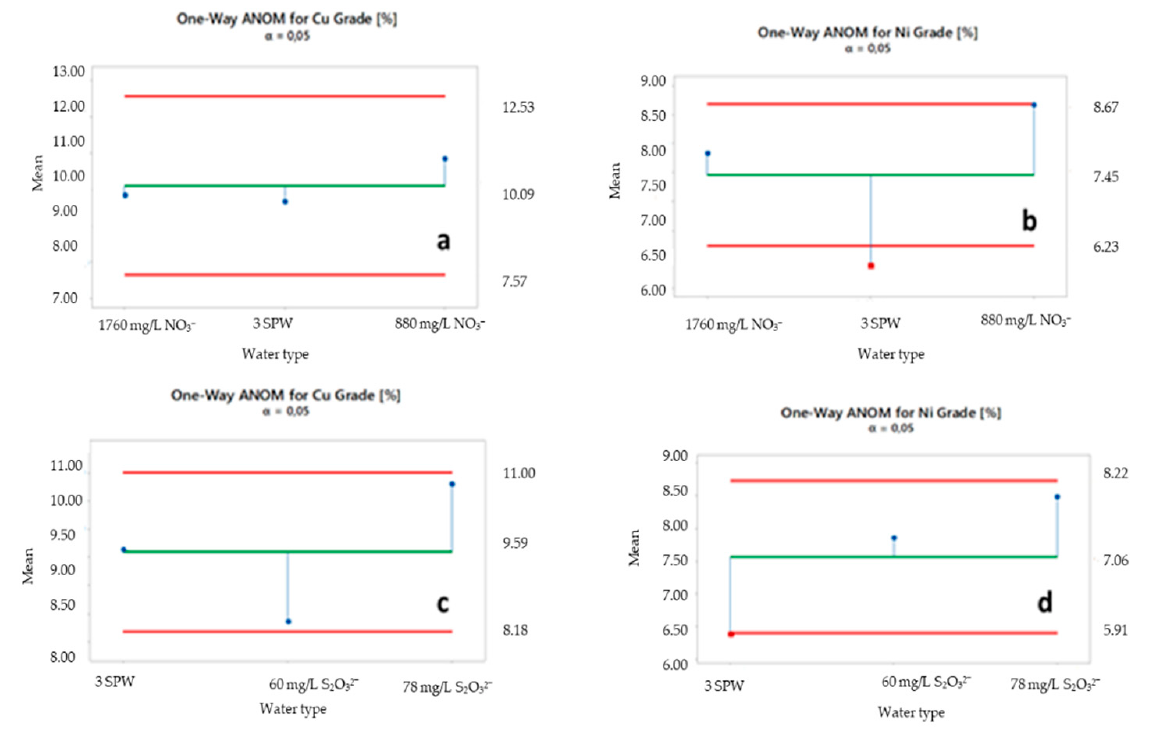
Figure 5. Statistical analysis of means (ANOM) on selected anions at 95% confidence intervals: ( a ) comparison between the baseline experiment 3 SPW with respect to copper grade and varied NO 3 − anion concentration; ( b ) comparison between the baseline experiment 3 SPW with respect to nickel grade and varied NO 3 − anion concentration; ( c ) comparison between the baseline experiment 3 SPW with respect to copper grade and varied S 2 O 32 − anion concentration; and ( d ) comparison between the baseline experiment 3 SPW with respect to nickel grade and varied S 2 O 32 − anion